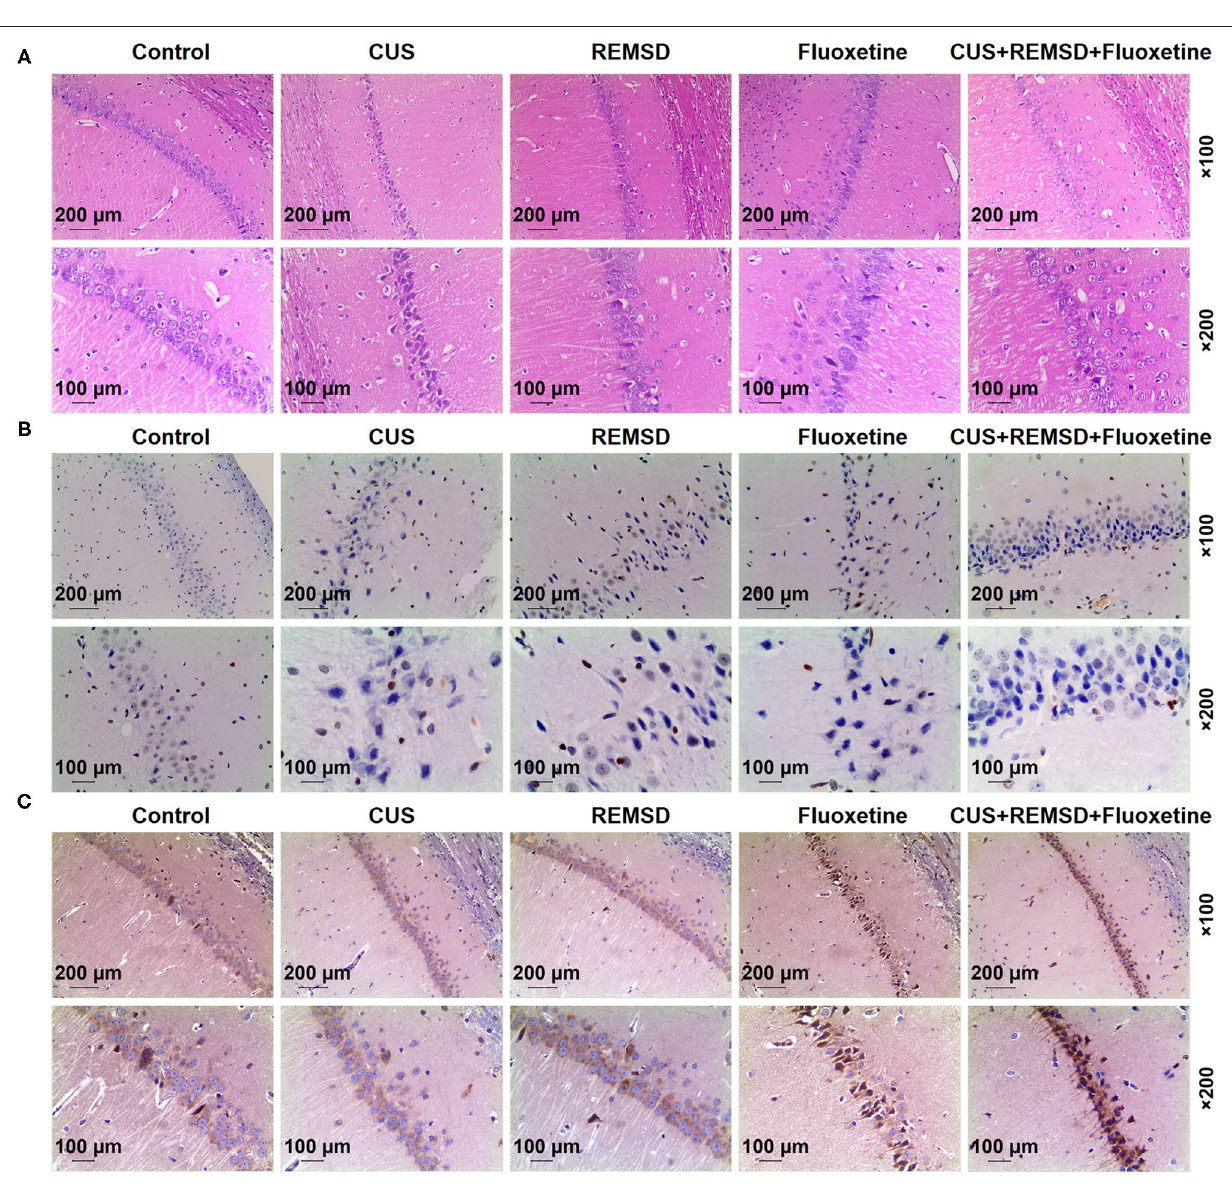
FIGURE 2 | REMSD combined with fluoxetine alleviated damage, attenuated apoptosis, and promoted A1 adenosine receptor level in hippocampi of rats with depression. (A) Histology of hippocampi of rats in control, CUS (depression), REMSD, fluoxetine, and REMSD + fluoxetine groups was observed by H&E staining, under × 100 and × 200 magnifications. (B) Apoptosis in hippocampi of rats in control, CUS (depression), CUS + REMSD, CUS + fluoxetine, and CUS + REMSD + fluoxetine groups was determined using TUNEL assay, under × 100 and × 200 magnifications. (C) Immunohistochemistry analysis of A1 adenosine receptor in rats in control, CUS (depression), CUS + REMSD, CUS + fluoxetine, and CUS + REMSD + fluoxetine groups, under × 100 and × 200 magnifications. H&E, hematoxylin–eosin; TUNEL, terminal transferase-mediated biotin 2 ′ -deoxyuridine, 5 ′ -triphosphate nick end labeling; REMSD, rapid eye movement sleep deprivation; CUS, chronic unpredictable